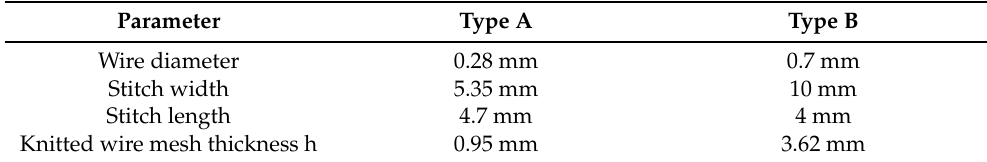
Table 1. Geometric parameters of the knitted wire meshes.